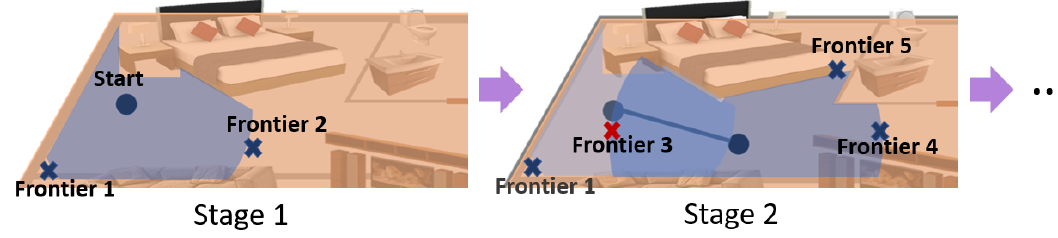
Figure 5. Sequence for the detection, classification and selection of frontiers in two exploration